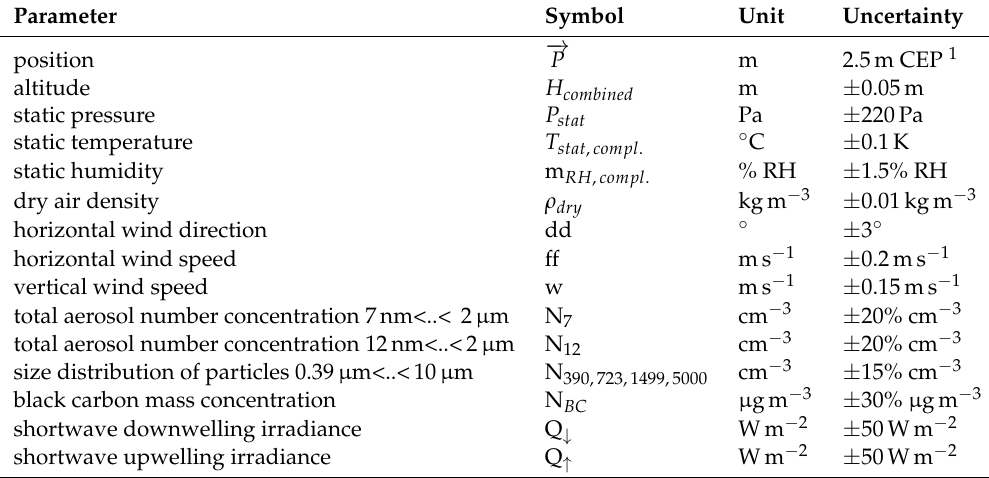
Table 1. Resulting parameters of the UAS(unmanned aerial systems) ALADINA (Application of Light-weight Aircraft for Detecting in situ